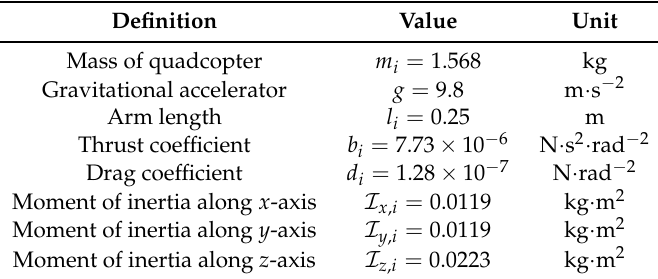
Table 2. The quadcopter parameter values in the